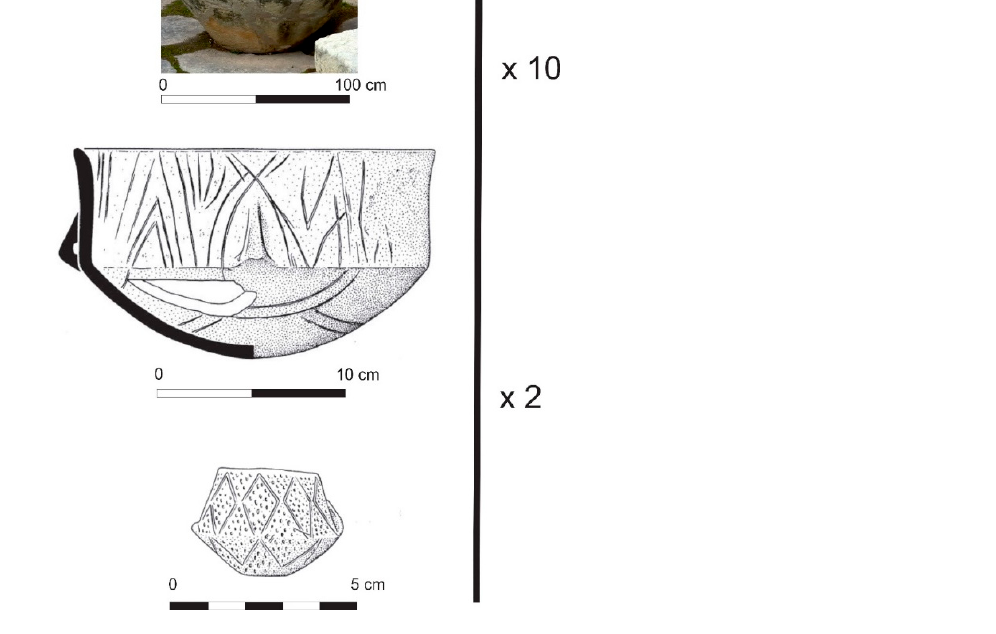
Figure 4. Scales of vessel.